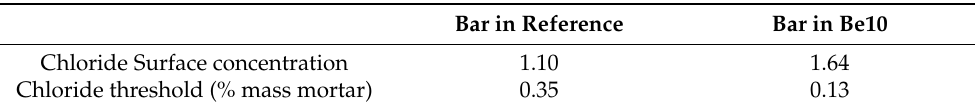
Table 4. Concentration of chlorides in the surface of the specimen at the end of the experiment and in the surface of the steel